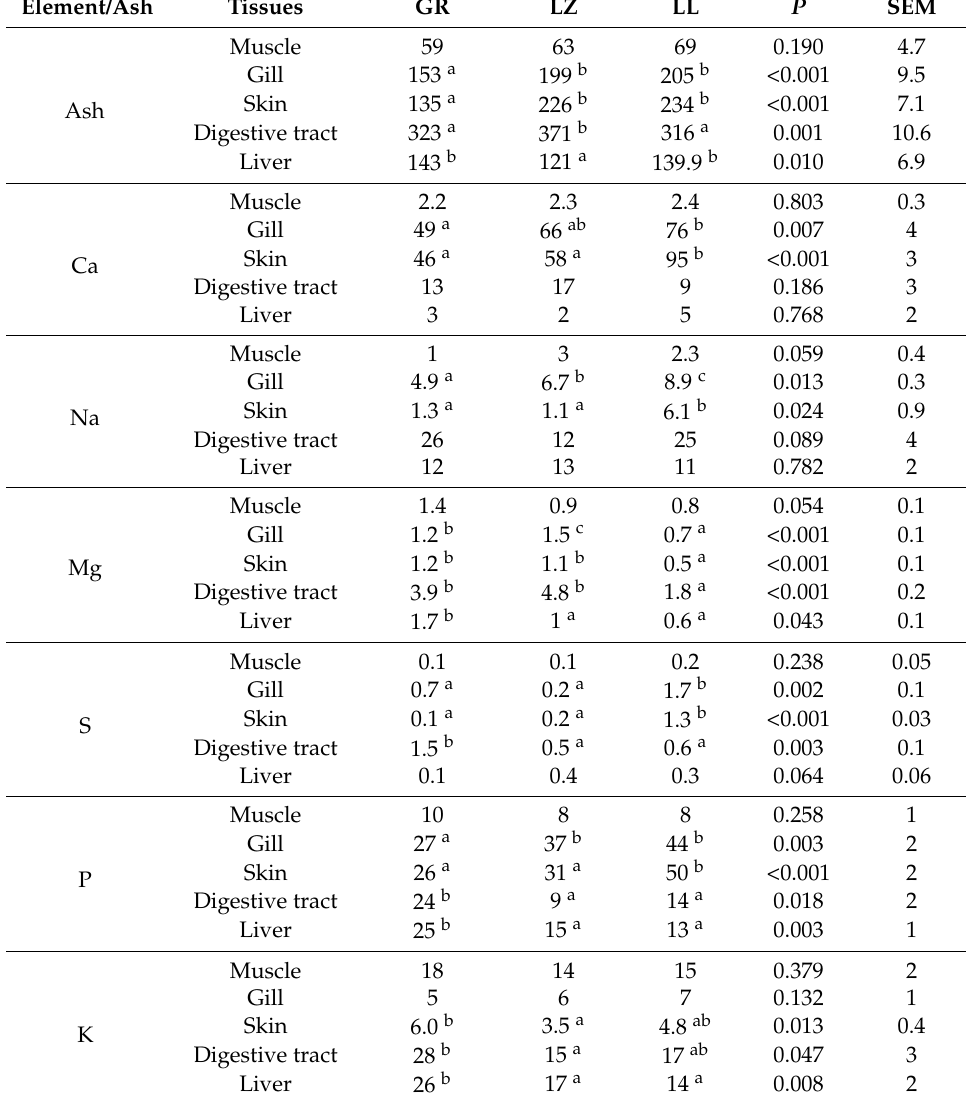
Table 3. The concentration of ash and macrominerals in Nile tilapia tissues from three lakes in Ethiopia (g/kg dry matter; pooled samples ( n = 3 from each lake)).